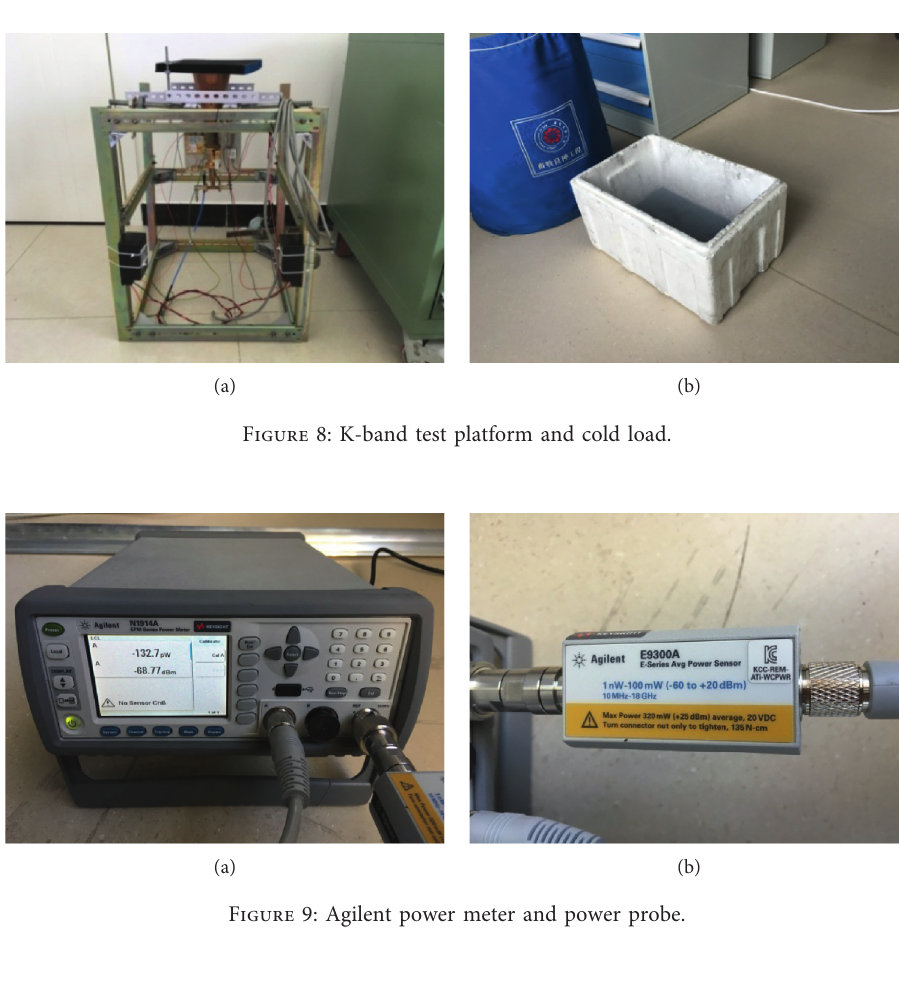
Table 2: Test data and comparison results for the cold and ambient load method.